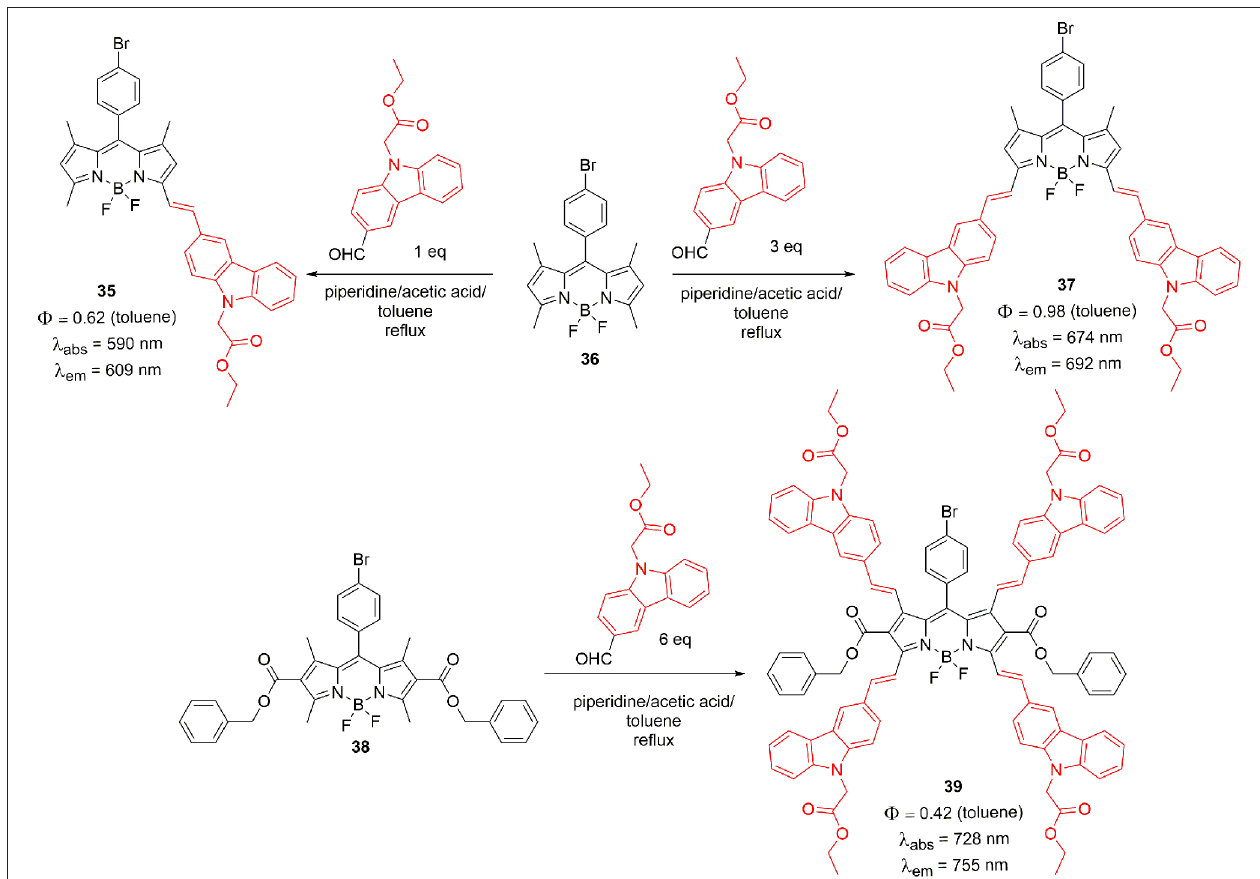
SCHEME 8 | Synthesis of star-shaped BODIPY